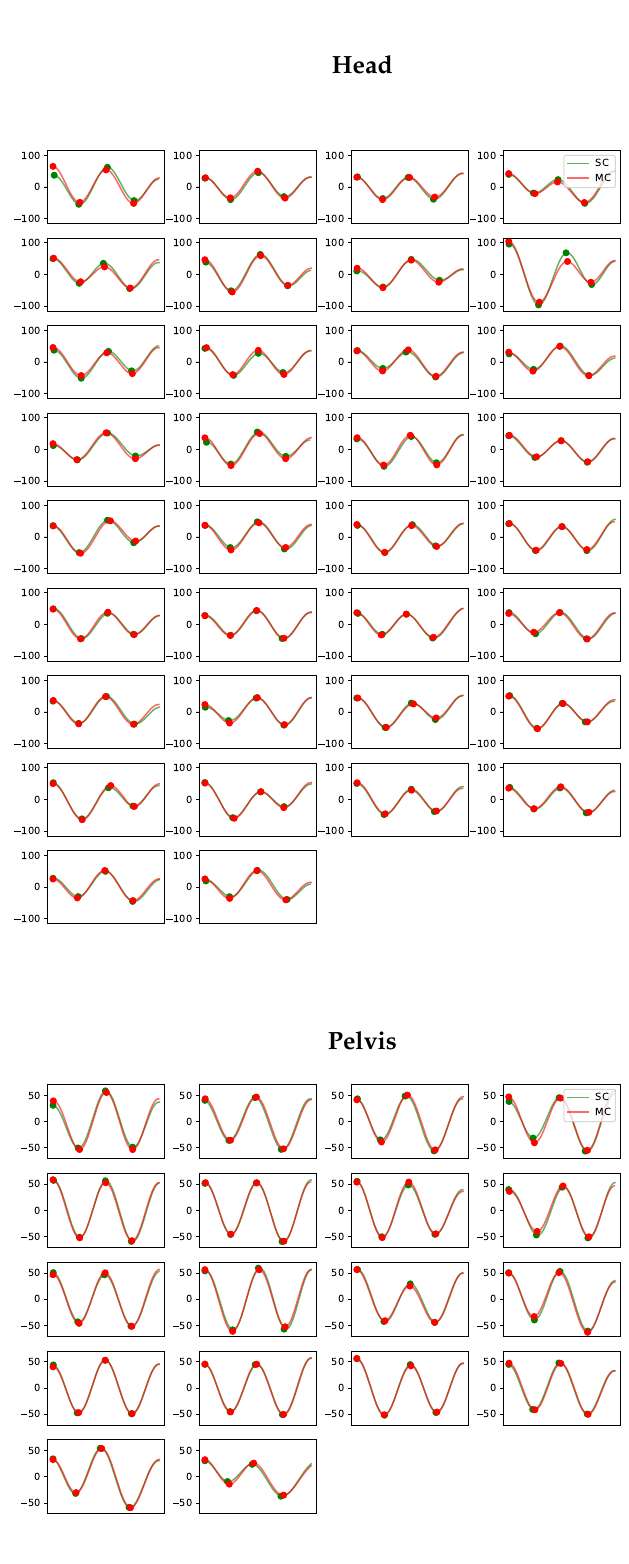
Figure A16. Vertical displacement signals per stride for the head and pelvis for horse 17. Each subplot contains the matched stride segments for the single-camera markerless system (SC) in green and the multi-camera marker-based system (MC) in red. The y-axis shows the vertical displacement in millimeters. The four dots on each curve indicate the positions of the two peaks and two valleys extracted using the approach in Section